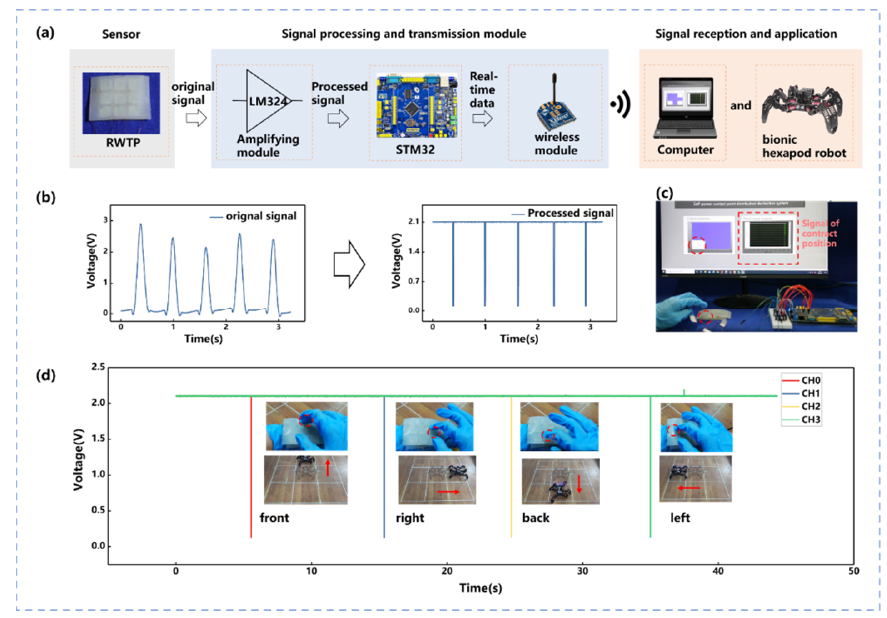
Figure 3. Self-powered contact position distribution detective system and real-time control of hexapod bionic robot based on RWTP. ( a ) Schematic diagram of the contact position sensing system and real-time control of robot based on RWTP. ( b ) Graph of RWTP signal change through signal process circuit. ( c ) Function demonstration of contact position sensing. ( d ) Schematic diagram of controlling the movement of the robot and its corresponding output voltage signal.